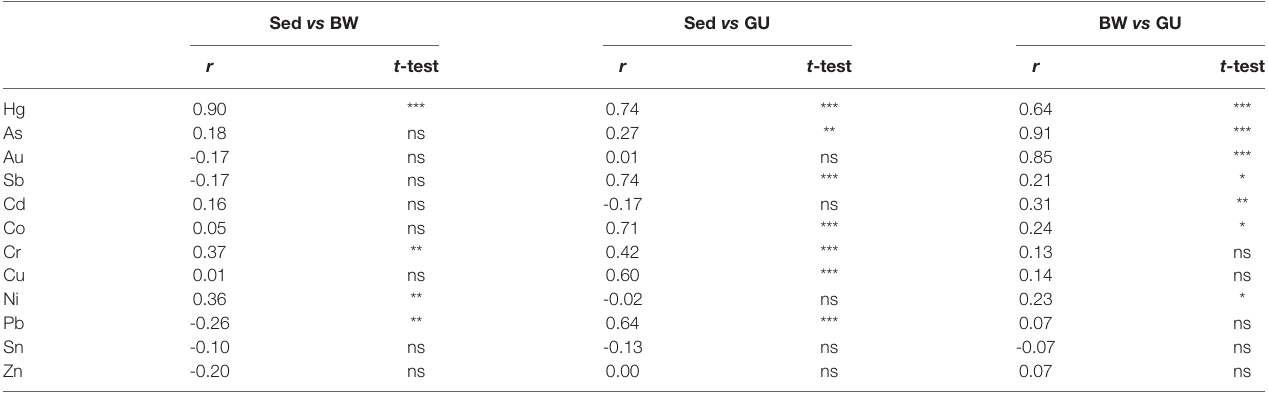
TABLE 1 | Pearson ’ s product-moment correlation coef fi cients ( r ) and corresponding t -tests for difference from zero of trace element concentrations between sediment (Sed) and body walls (BW) or guts (GU), and between body wall (BW) and guts (GU) (n =